Question: Compose a caption that would accompany this figure in a paper.
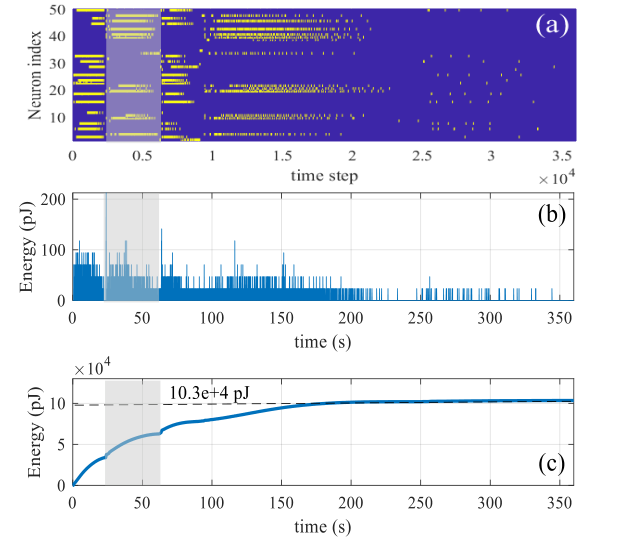
Answer: (a) Spiking pattern, (b) Energy consumed per  time step, and (c) Total energy consumption for satellite